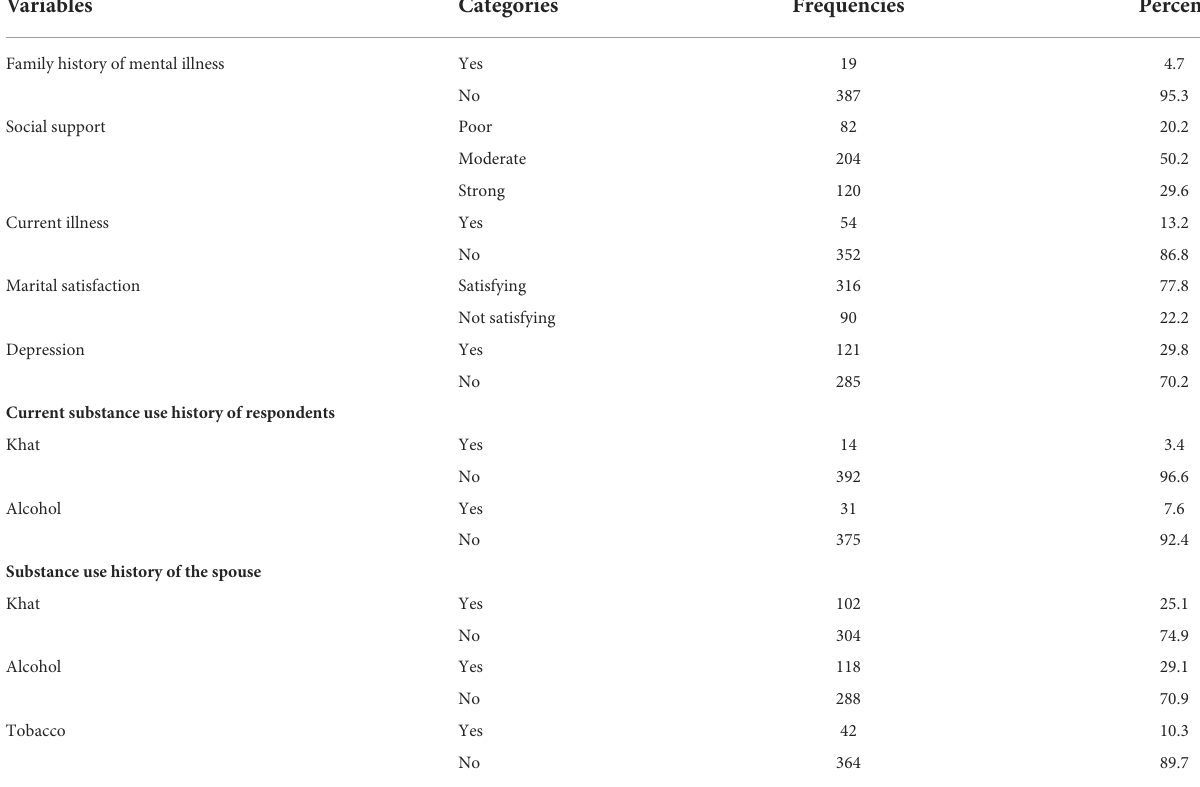
TABLE 2 Psychosocial, substance use, and health-related characteristics of pregnant women attending antenatal clinic follow-up at Bedelle general hospital and Metu Karl comprehensive specialized hospital, 2021 ( N =